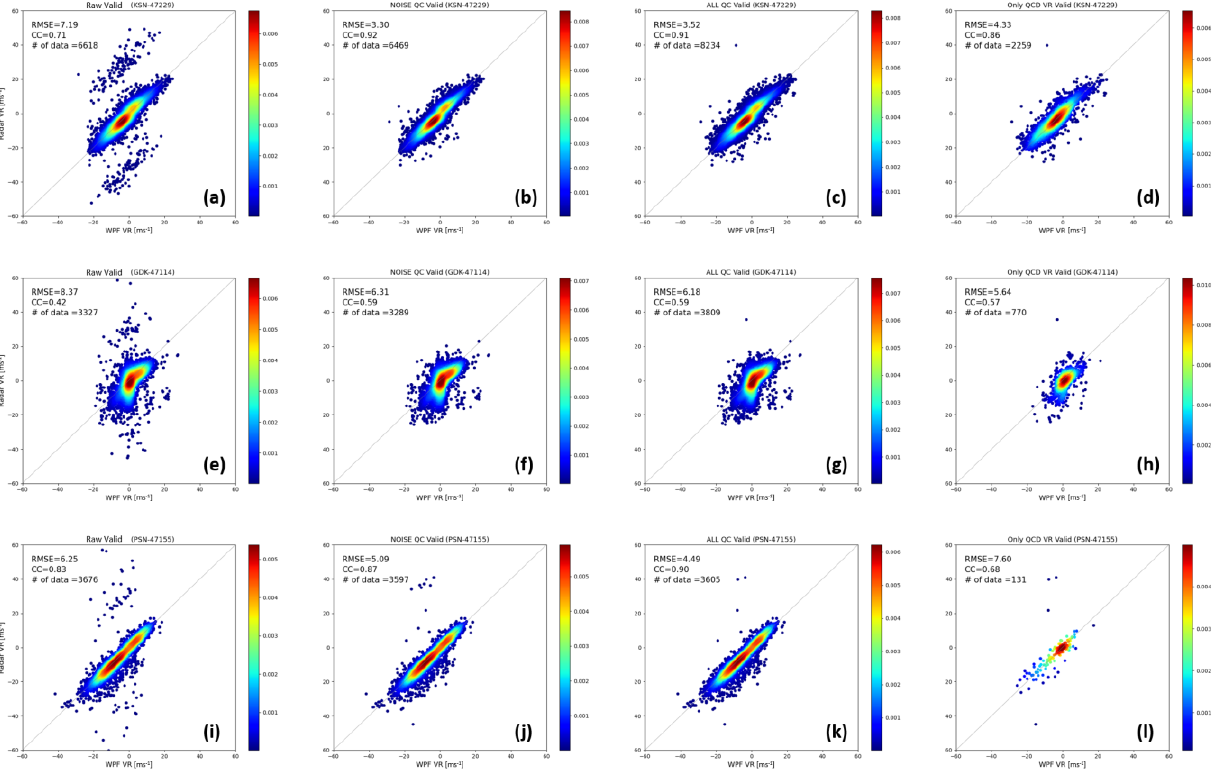
Figure 16. ( top ) RMSE and ( bottom ) CC for each QC stage and QCD of ten pairs. RAW is actual radial velocity, excluding non-precipitation echoes from raw data. NOS is noise-corrected radial velocity in RAW. ALL is the radial velocity after quality control. QCD is only quality-controlled radial velocity excluding actual observations. Table 3. Quantitative verification results for each stage of the radial velocity quality control tech- nique.